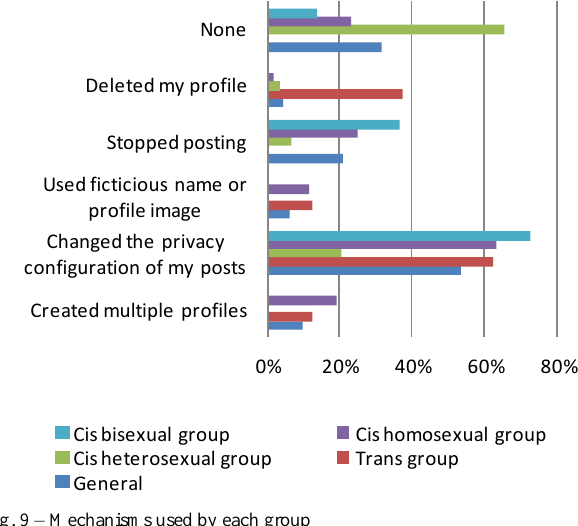
Fig. 9 – Mechanisms used by each group In general, to change the privacy configuration was the preferred mechanism of volunteers. 37.5% of the trans group has already opted to delete the profile, showing a bigger proclivity for this option when compared to other groups (1.9% of cis homosexuals and 0% of cis bisexuals chose it). On the other hand, no trans has given up posting, while 36.4% of the cis bisexual and 25% of cis homosexual population